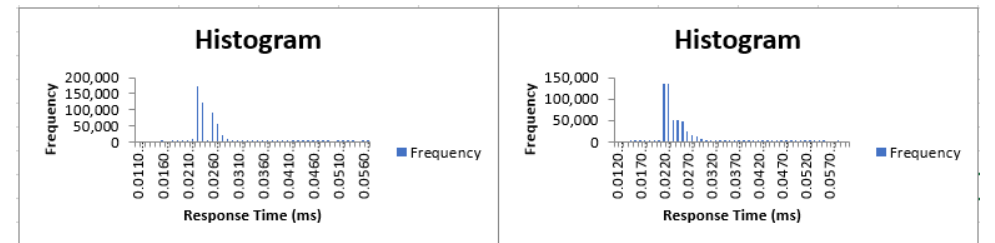
Figure 7. High data load from Node 1 to Node 2 ( left ) Node 3 t o Node 2 ( right